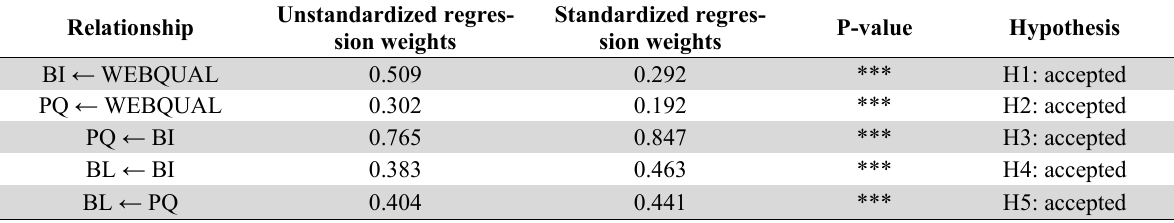
Test result of relationships among factors Unstandardized regres- Relationship sion